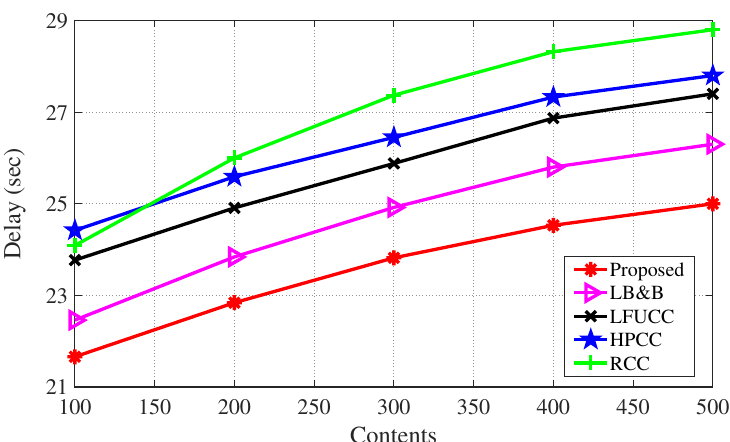
Figure 3. Impact of number of contents on the network delay when N = 50 and γ =